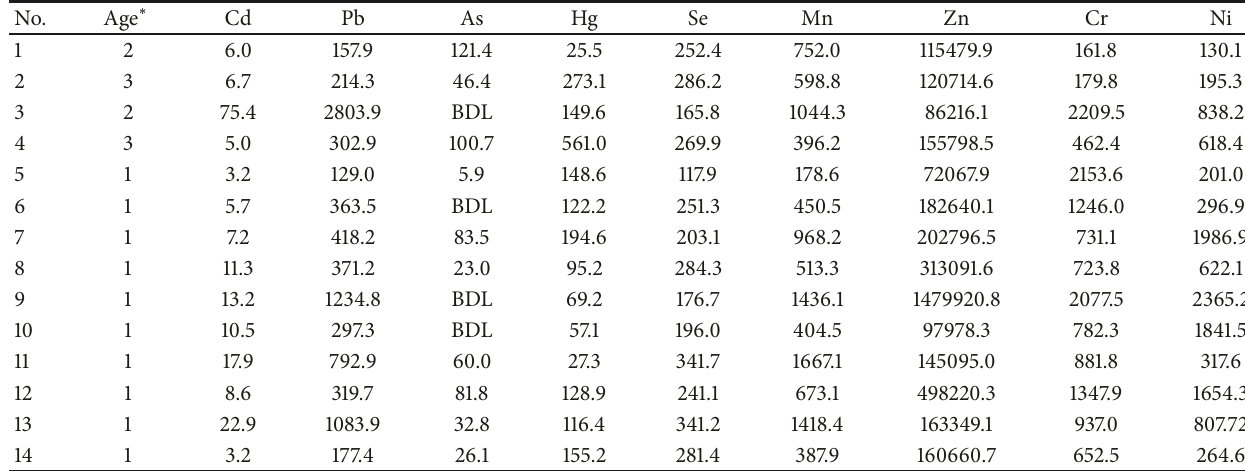
Table 4: Toxic elements levels in nonsmokers human hair ( 𝜇 g/kg).